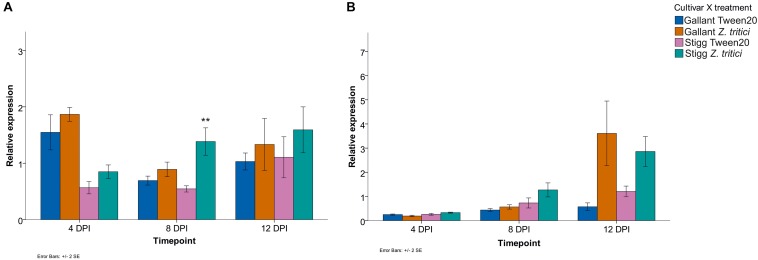
Relative expression of (A) TaSRTRG6 (A,B) TaSRTRG7 in the STB susceptible and resistant cvs. Gallant and Stigg in response to inoculation with Zymoseptoria tritici isolate Cork Cordiale 4 (at 4, 8, and 12 dpi). Results are based on three independent trials, each including four pooled plant samples per treatment per cultivar per time point combination which were bulked and subsampled twice for RNA extraction (resulting in 3 composite biological × 2 technical replicates per treatment per time point per genotype). Gene expression was assessed at 4, 8, and 12 dpi (days post inoculation) with either a Tween20 or Z. tritici application. Y-axis delta CT values are relative expression values of treatments calculated using the 2(–ΔΔCt) formula using the average of two housekeeper genes GAPDH and Alpha tubulin. Bars indicate SEM. **p ≤ 0.01.